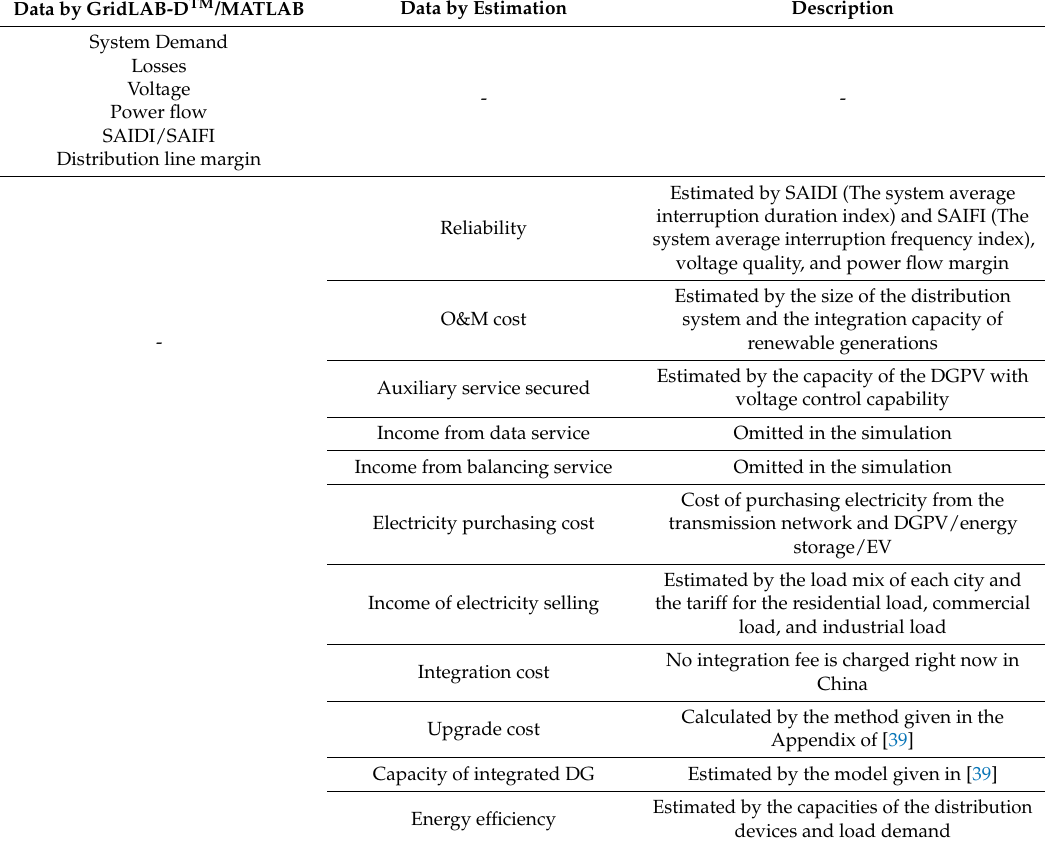
Table 9. Introduction of data for the calculation of the sustainable development level